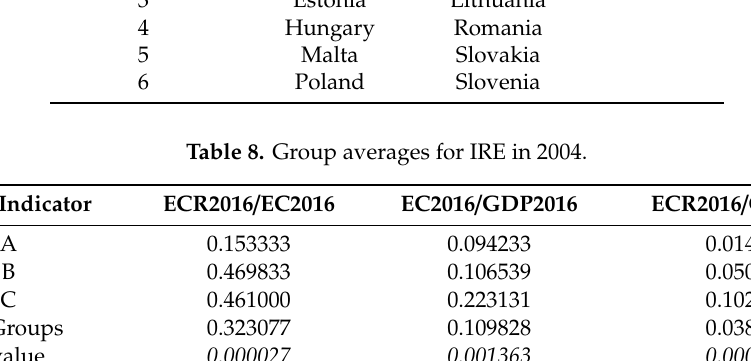
Table 7. Clusters for IRE in 2016.